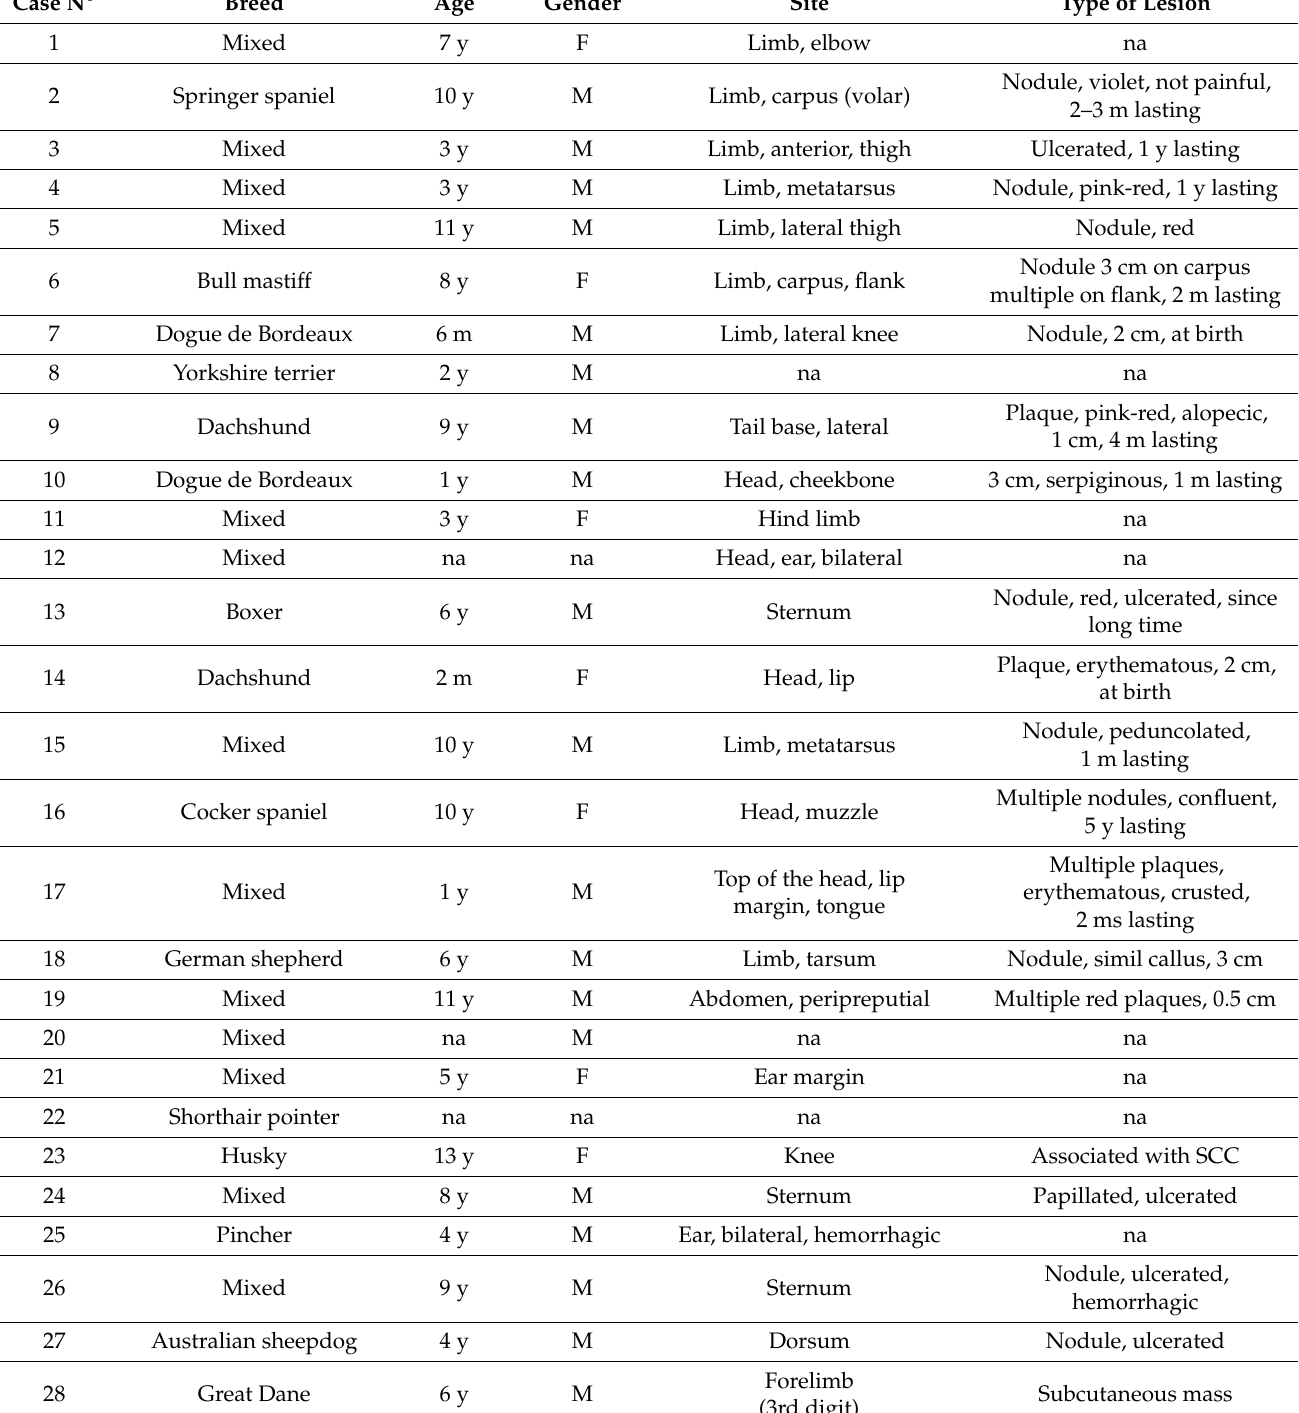
Table 1. Data on signalment, type and distribution of lesions (m = month, y = year, na = not